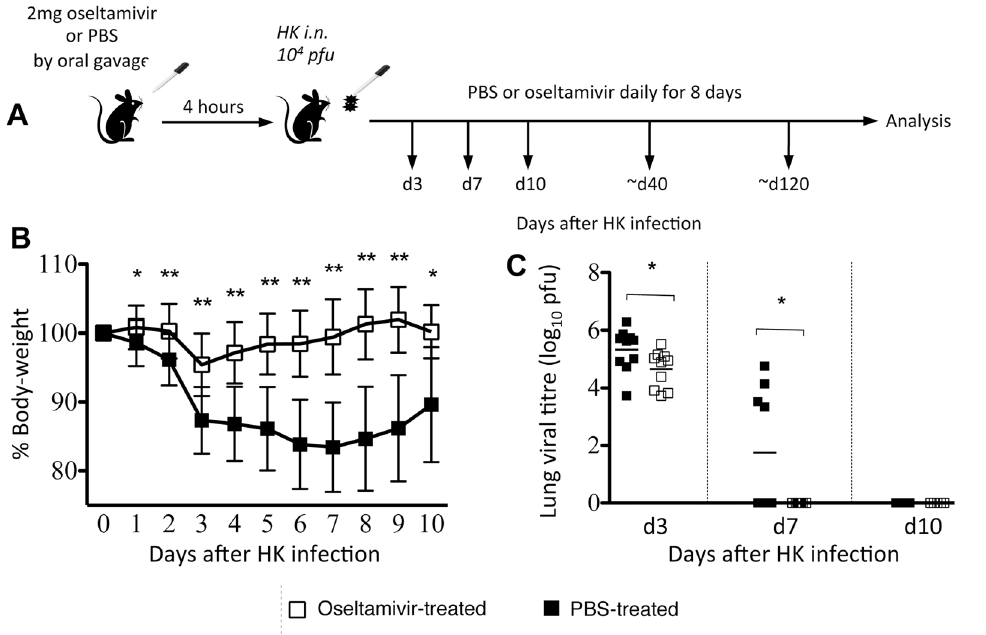
Fig 1. Oseltamivir prophylaxis ameliorates disease severity by reducing weight loss and accelerating viral clearance in influenza virus-infected mice. (A) Na ï ve female BL/6 mice were orally administered either 2mg oseltamivir in PBS or PBS alone 4 hrs prior to i.n. infection with 10 4 pfu of HK, and once daily for 8 days thereafter. (B) Mice were monitored daily for weight loss. Data represent the mean and standard deviation of 8 separate experiments each with 4 – 5 mice per group. (C) Lungs were homogenised and clarified supernatants were plaqued on MDCK cell monolayers to determine viral titres. Symbols denote individual mice and the mean is shown for each group. Data were pooled from 2 independent experiments each with 4 – 5 mice per group. * P < 0.05, ** P < 0.01.